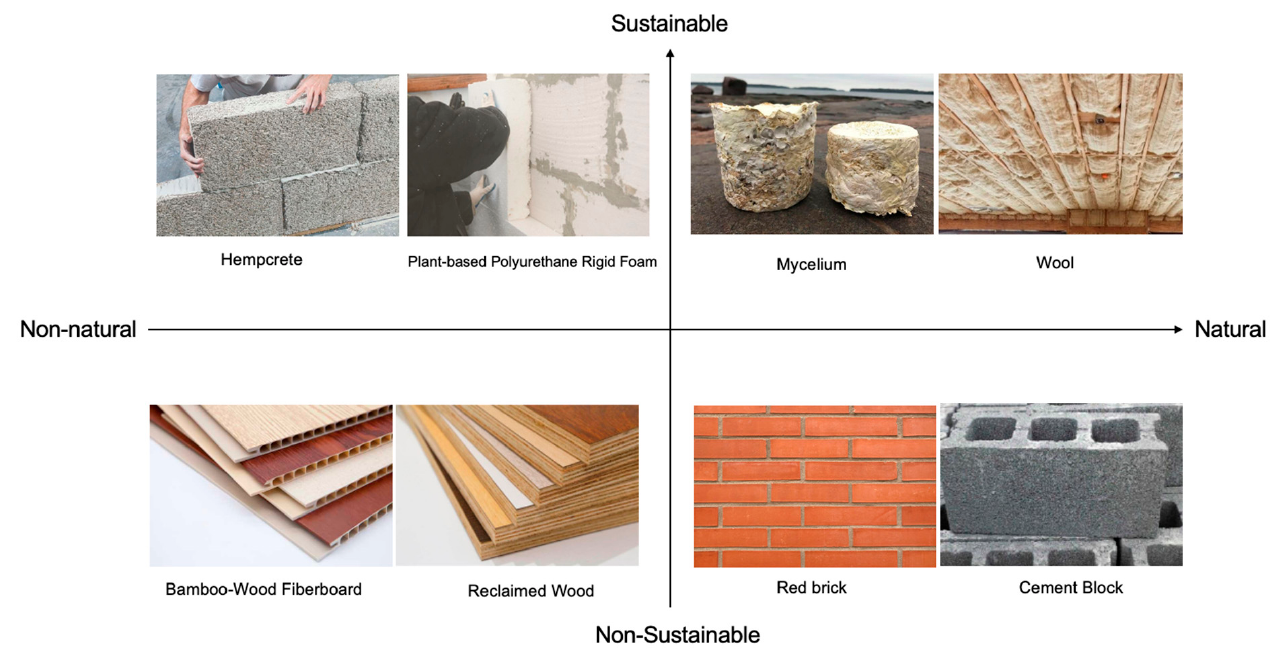
Figure 2. Experimental Stimuli with two dimensions